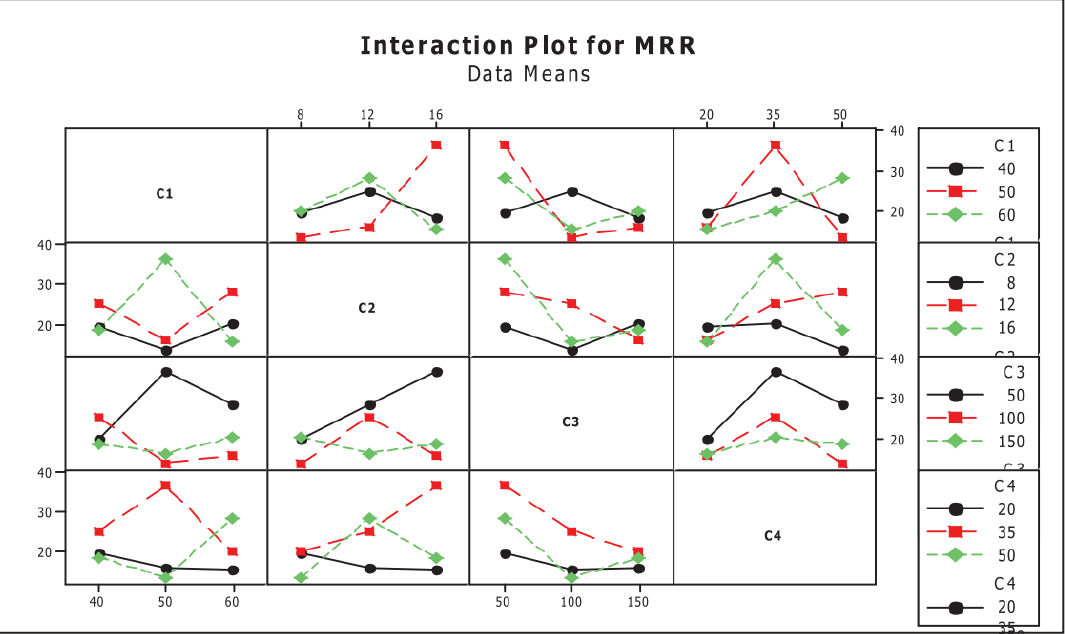
Figure 9. Interaction plot of the material removal rate (MRR) [157].